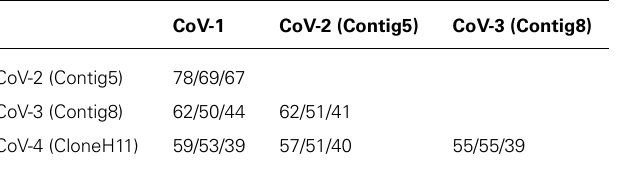
Table 2 | RNA-dependent RNA polymerase/heat shock protein 70 homolog/coat protein amino acid percent identities between the CoVs infecting common green ti